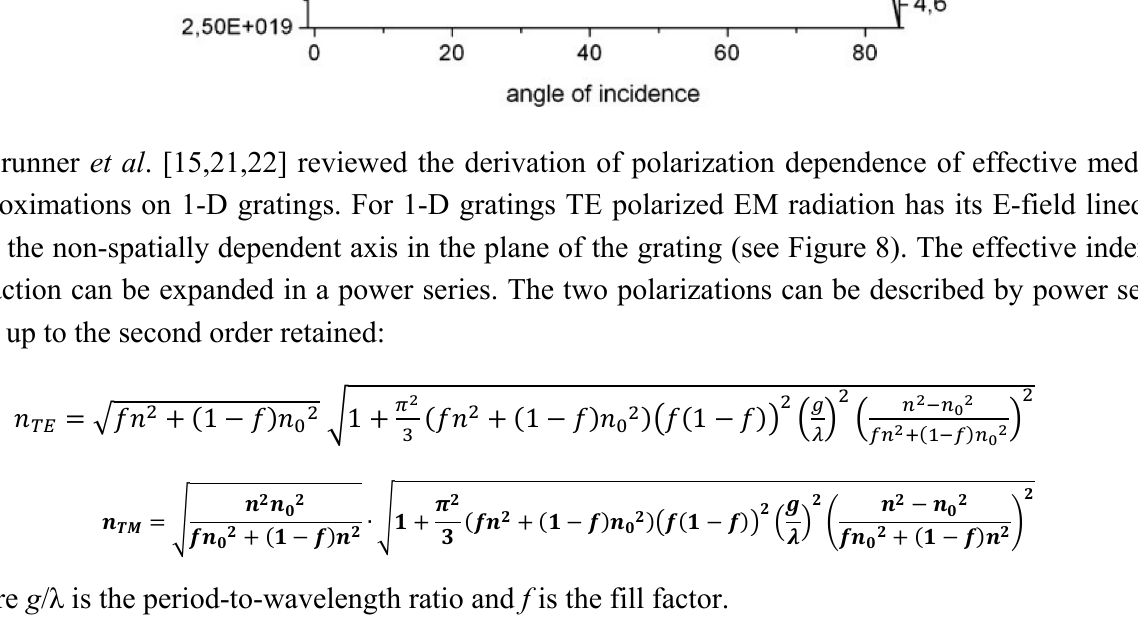
Figure 8. TE and TM polarization hitting a 1-D grating. The wavevector is indicated as k